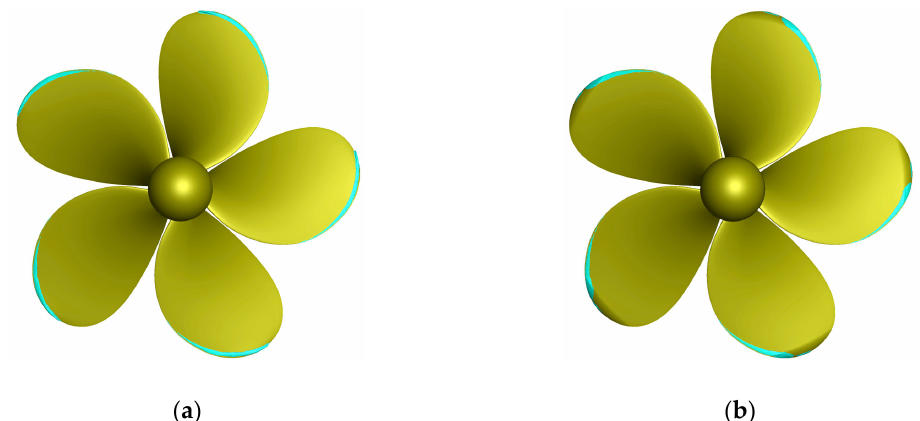
Figure 22. Iso-surface of 30% vapor volume fraction: ( a ) benchmark propeller and ( b ) winglet-propeller.